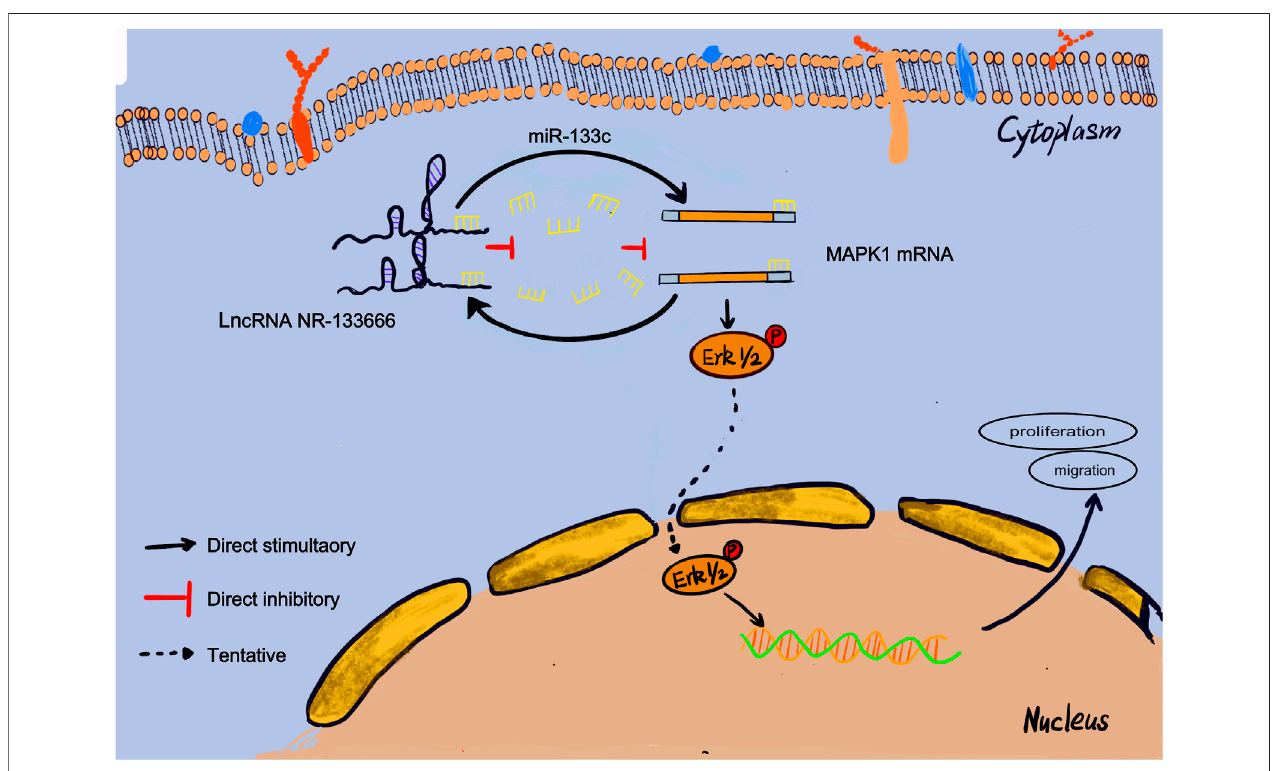
FIGURE 8 | Mechanistic model. This schematic diagram represents the potential molecular mechanism that lncRNA NR-133666 promotes the proliferation and migration of CIA FLS and indirectly upregulates MAPK1 and ERK phosphorylation to activate ERK signaling by regulating miR-133c.